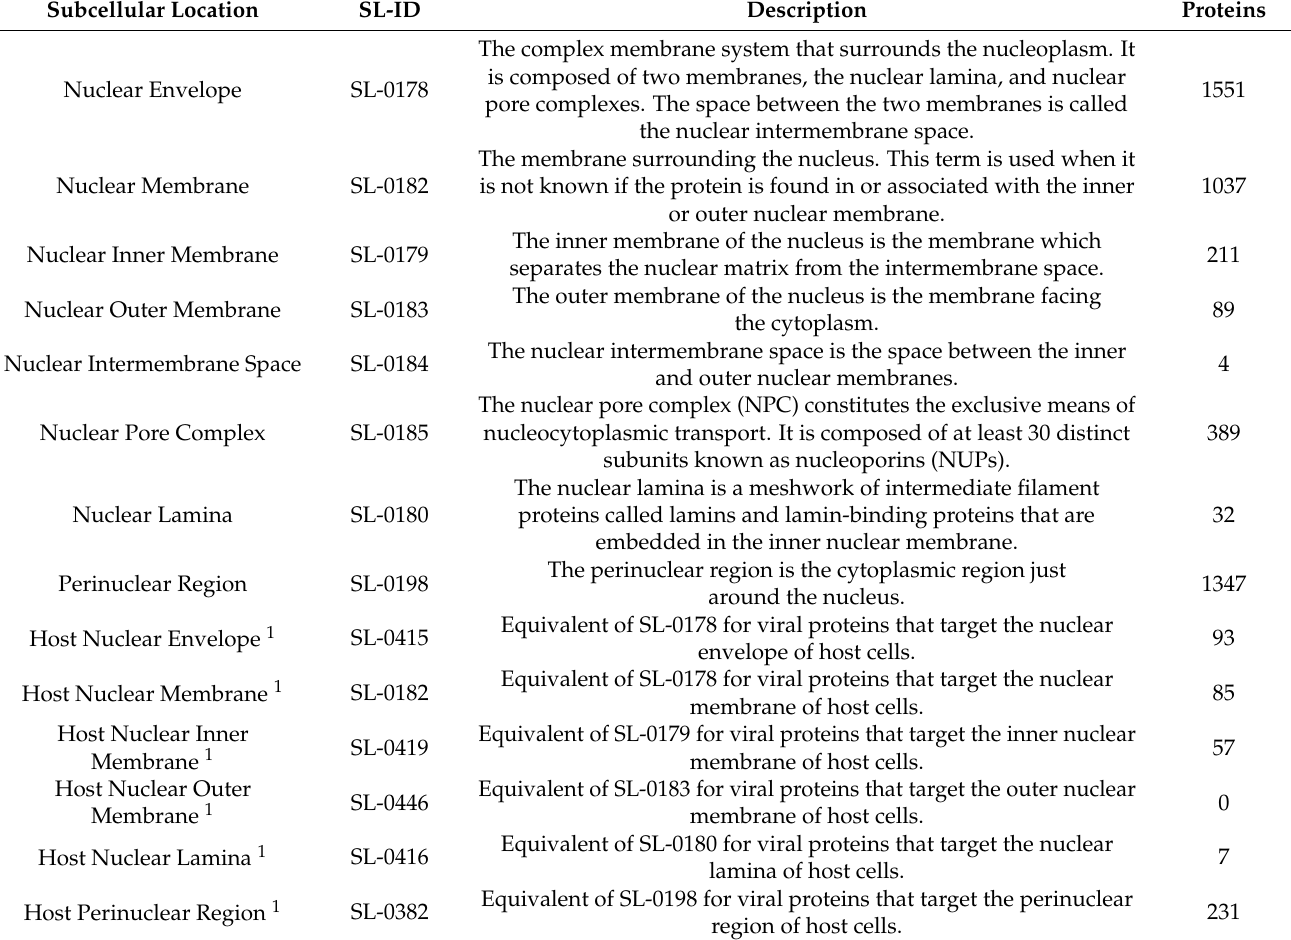
Table 1. List of subcellular locations assigned to the Nuclear Envelope. The name, UniProt identifier (SL-ID), and description of each location are given, as well as the number of NucEnvDB entries that have been assigned to each